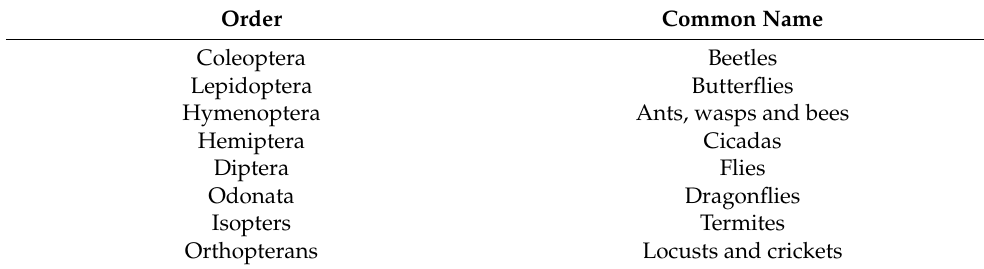
Table 7. Edible insects for human food intake (adapted from [73]).